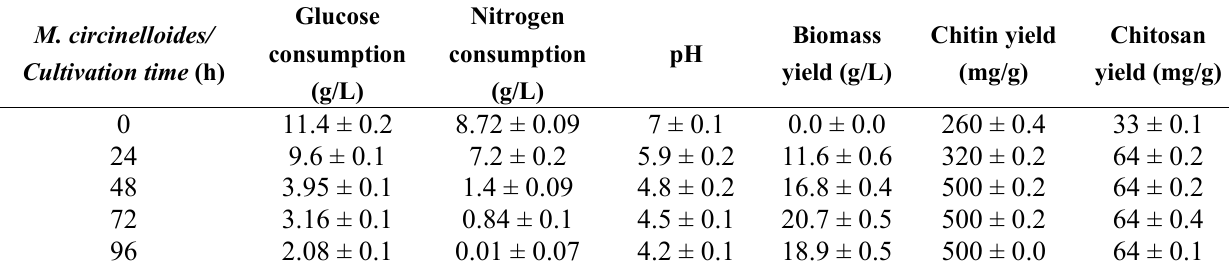
Table 1. Profile of growth of M. circinelloides UCP 050 in yam bean medium at 28 °C, 150 rpm, during 96 hours of cultivation, describe glucose and protein consumption, pH ranger, biomass (g/L), chitin and chitosan yields (mg/mL ) .